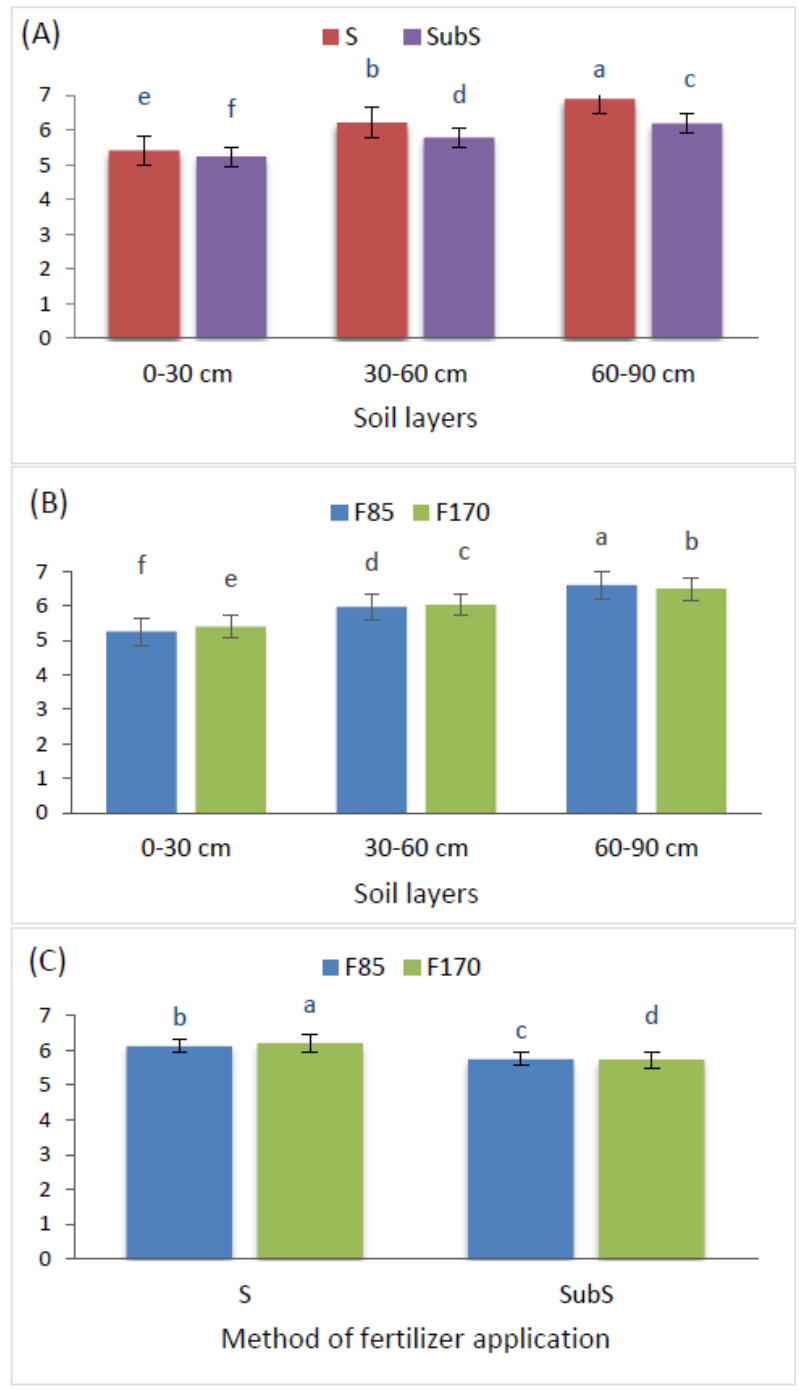
Figure 2. Effect of the interaction of the experimental factors on soil pH: ( A ) Method of fertilizer application × soil layer; ( B ) Fertilizer dose × soil layer; ( C ) Method of fertilizer application × fertilizer dose (S—Surface fertilizer application, SubS—Subsurface fertilizer application; F85—fertilizer dose 85 kg NPKS · ha − 1 ; F170—fertilizer dose 170 kg NPKS · ha − 1 ); different letters indicate significant differences ( p = 0.05).